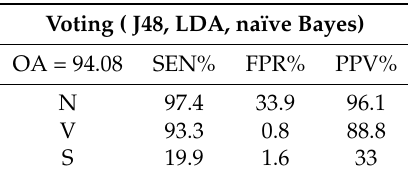
Table 19. Performance measures for combining J48, LDA, and naïve Bayes classifiers using Voting scheme (N,S,V).